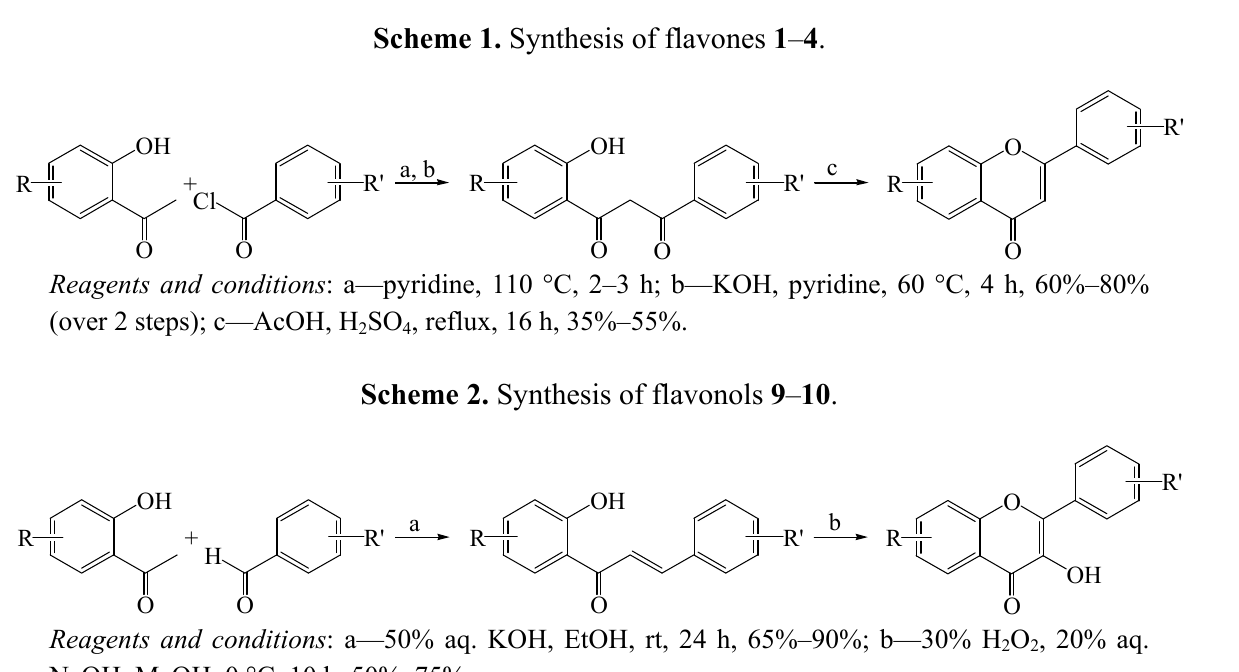
Table 1. Substituent patterns and M